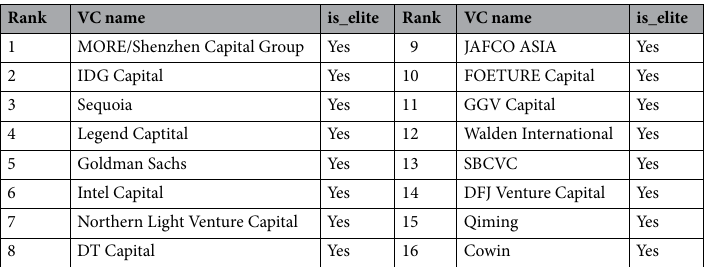
Table 2. The top 16 VC firms that attract the most attention in Attention Rank